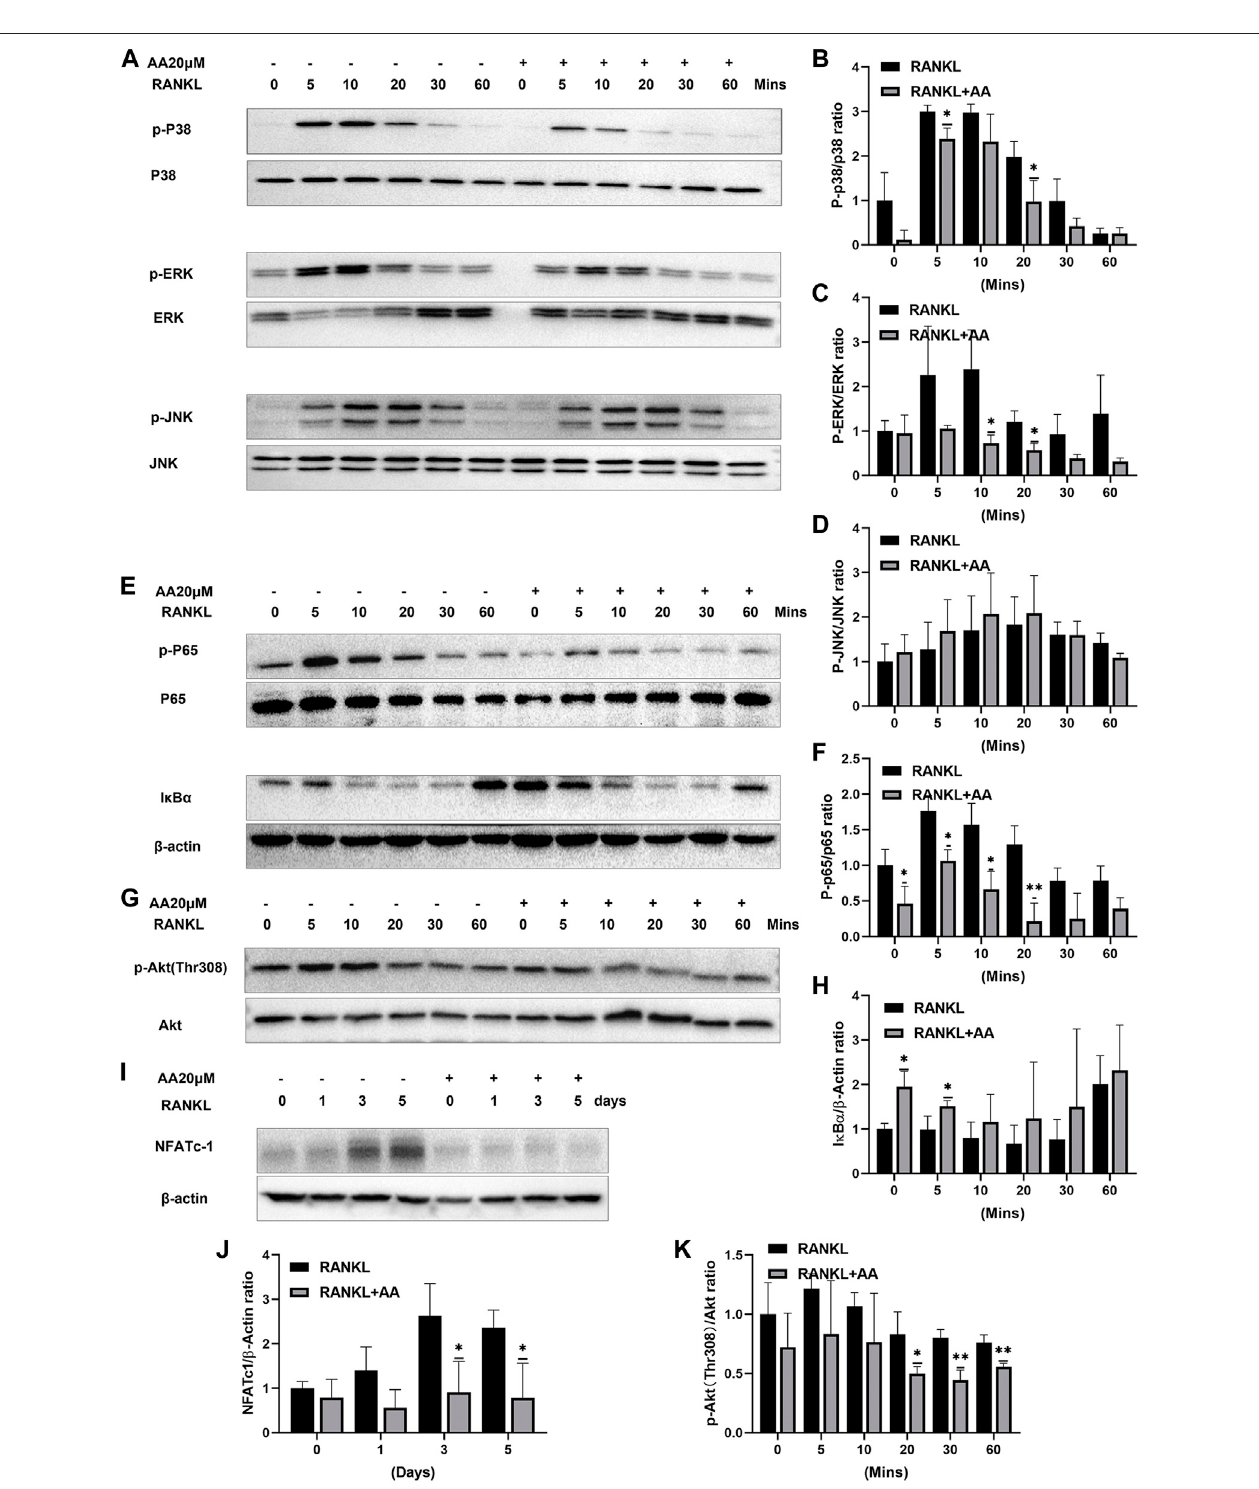
FIGURE3| AsiaticacidregulatesNFATc1expressionbyinhibitingtheNF- κ B/MAPK/Aktsignalingpathway. (A) RepresentativeWesternBlotimagesoftheeffectof asiaticacidontheMAPKpathway.After2 hofstarvation,BMMswerestimulatedfor2 hwithorwithoutasiaticacid(20 μ M).BMMswerestimulatedwithRANKLfor0,5, 10,20,30,and60 min (B – D) QuantitativeanalysesoftheexpressionofP-p38,P-ERK,P-JNK,p38,ERKandJNK( n =3). (E) RepresentativeWesternBlotimagesofthe effectofasiaticacidontheNF- κ Bpathway. (F,H) QuantitativeanalysesoftheexpressionofP-p65,p65andI κ B α ( n =3). (G) RepresentativeWesternBlotimagesof the effect of asiatic acid on the Akt pathway. (K) Quantitative analyses of the expression of P-Akt and Akt ( n = 3). (I) Representative Western Blot images of the effect of asiatic acid on NFATc1. BMMs were stimulated with RANKL for 0, 1, 3, and 5 days in the presence or absence of asiatic acid (20 μ M). (J) Quantitative analyses of the expression of NFATc1 ( n = 3). All values are presented as the mean ± SD ( n = 3). * p < .05; ** p < .01 compared with the control group (without AA treatment).